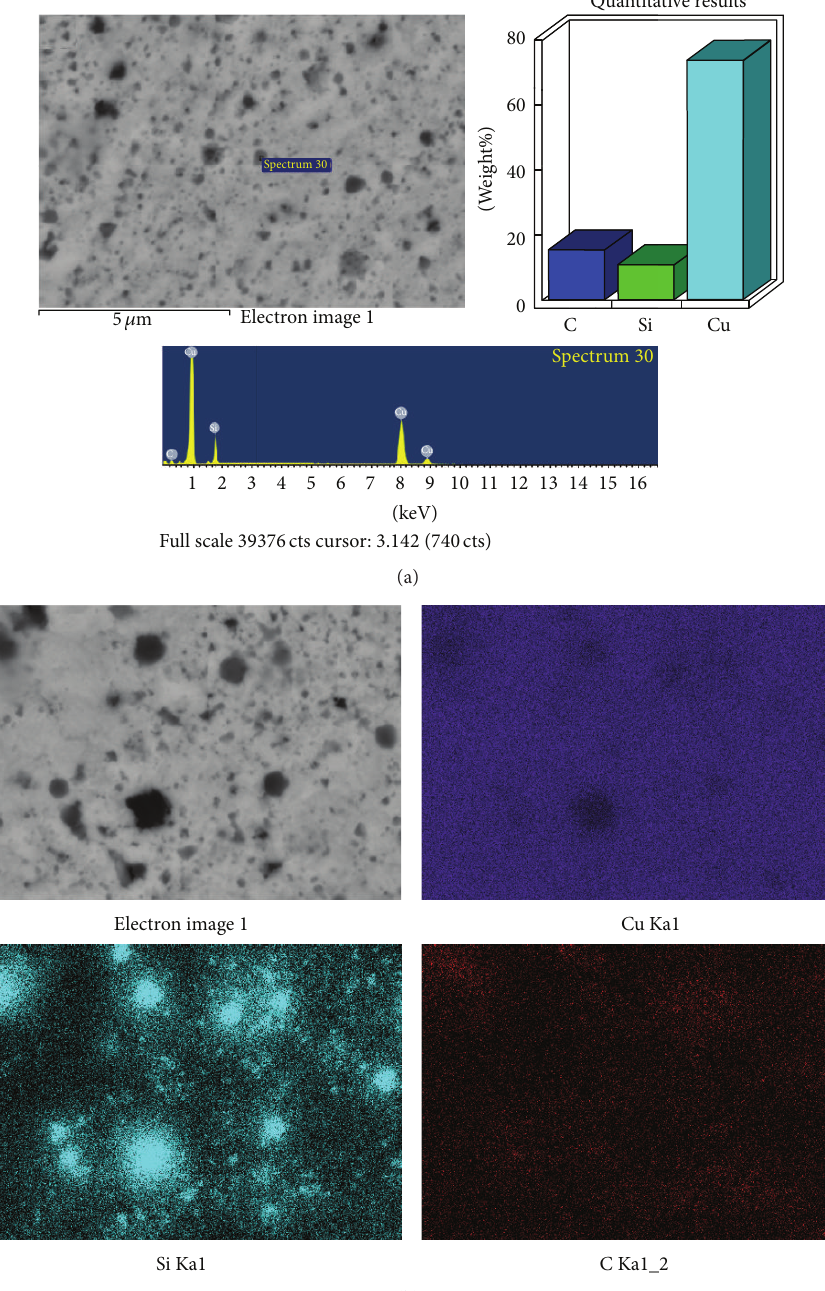
Figure 8: (a) EDAX report of a sample processed at (a) 500rpm/35 mm/min/2 ∘ and (b) mapping image of a sample processed at 1000 rpm/20mm/min/1 ∘